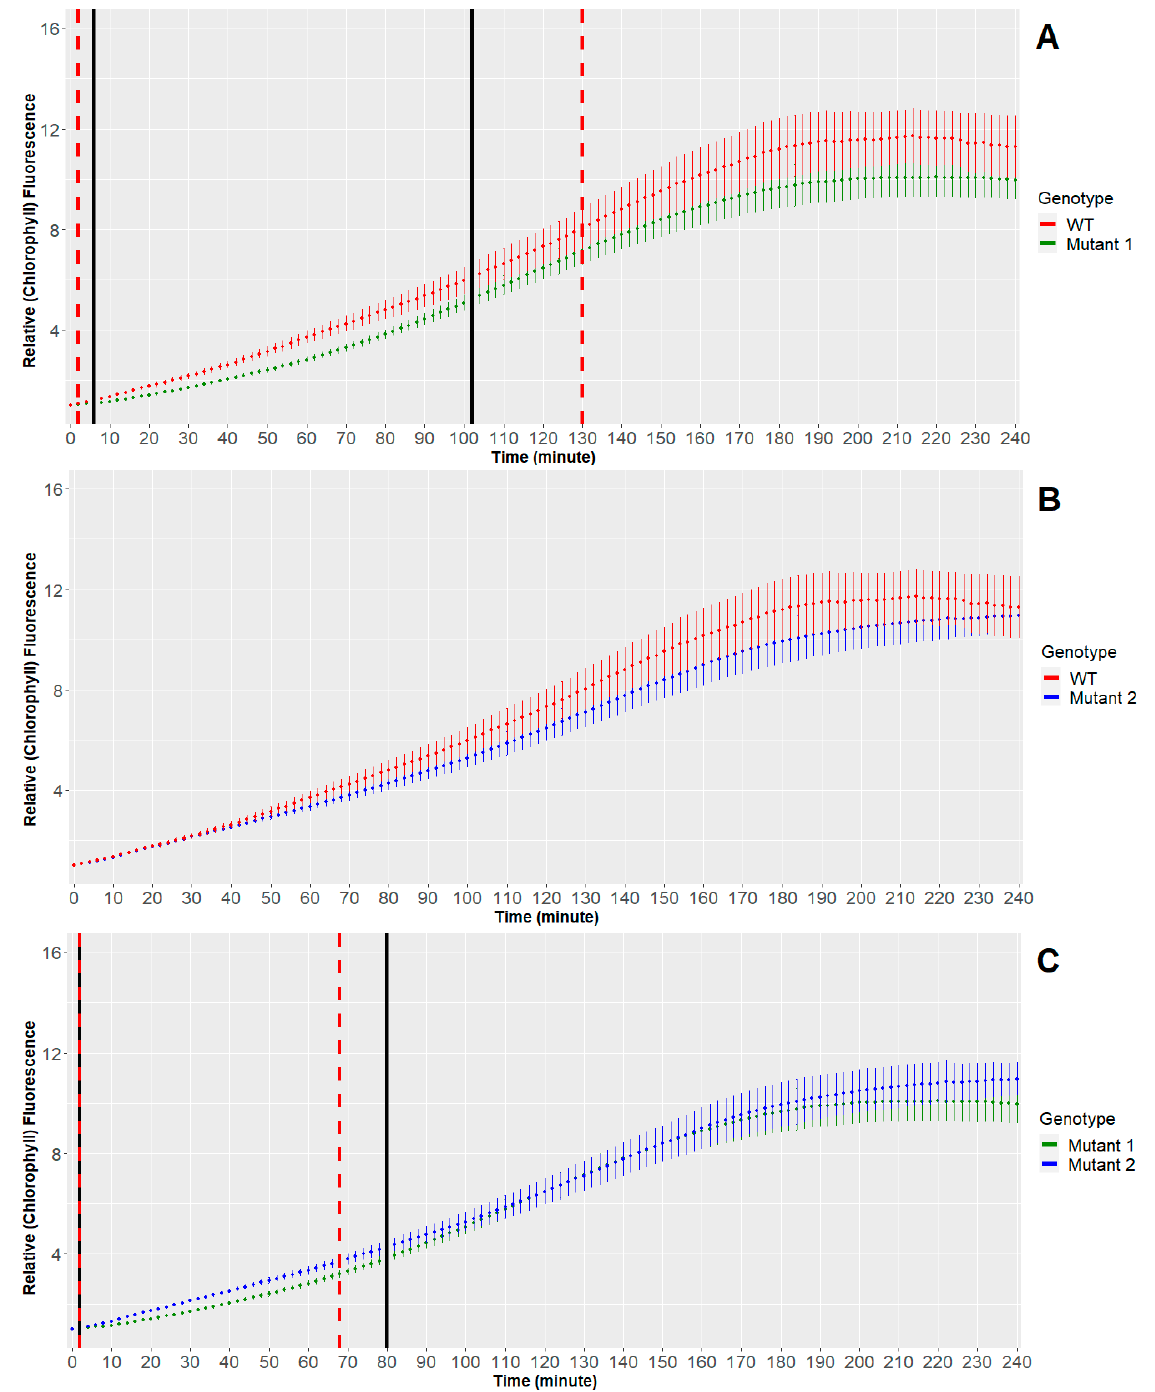
Figure 5. Pairwise comparisons of genotypes for each time point. The intervals inside the solid black vertical lines are considered as significantly different. The intervals inside the dashed red lines are the wrong results we would have if we did not take the autocorrelation into consideration. ( A ) There are significant differences in the chlorophyll dynamics between WT and Mutant 1 from 6 min to 102 min after the first measurement. Without considering autocorrelations, the (wrong) result would be from 2 min to 130 min (dashed red lines). ( B ) There are no significant differences found between WT and Mutant 2. ( C ) There are significant differences in the chlorophyll dynamics between Mutant 1 and Mutant 2 from 2 min to 80 min after the first measurement. Without considering autocorrelations the (wrong) result would be from 2 min to 68 min (dashed red lines).